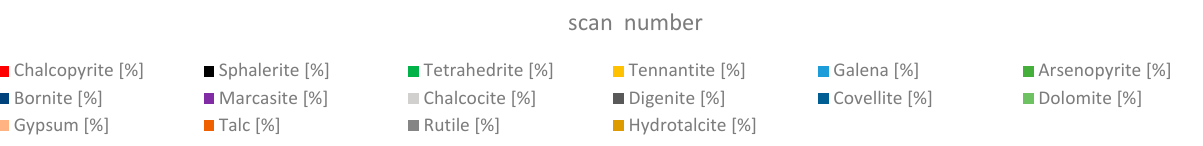
Figure 6. Mineralogical variability of ore blends for minor mineralogical phases, as determined by XRD and Rietveld refinement.